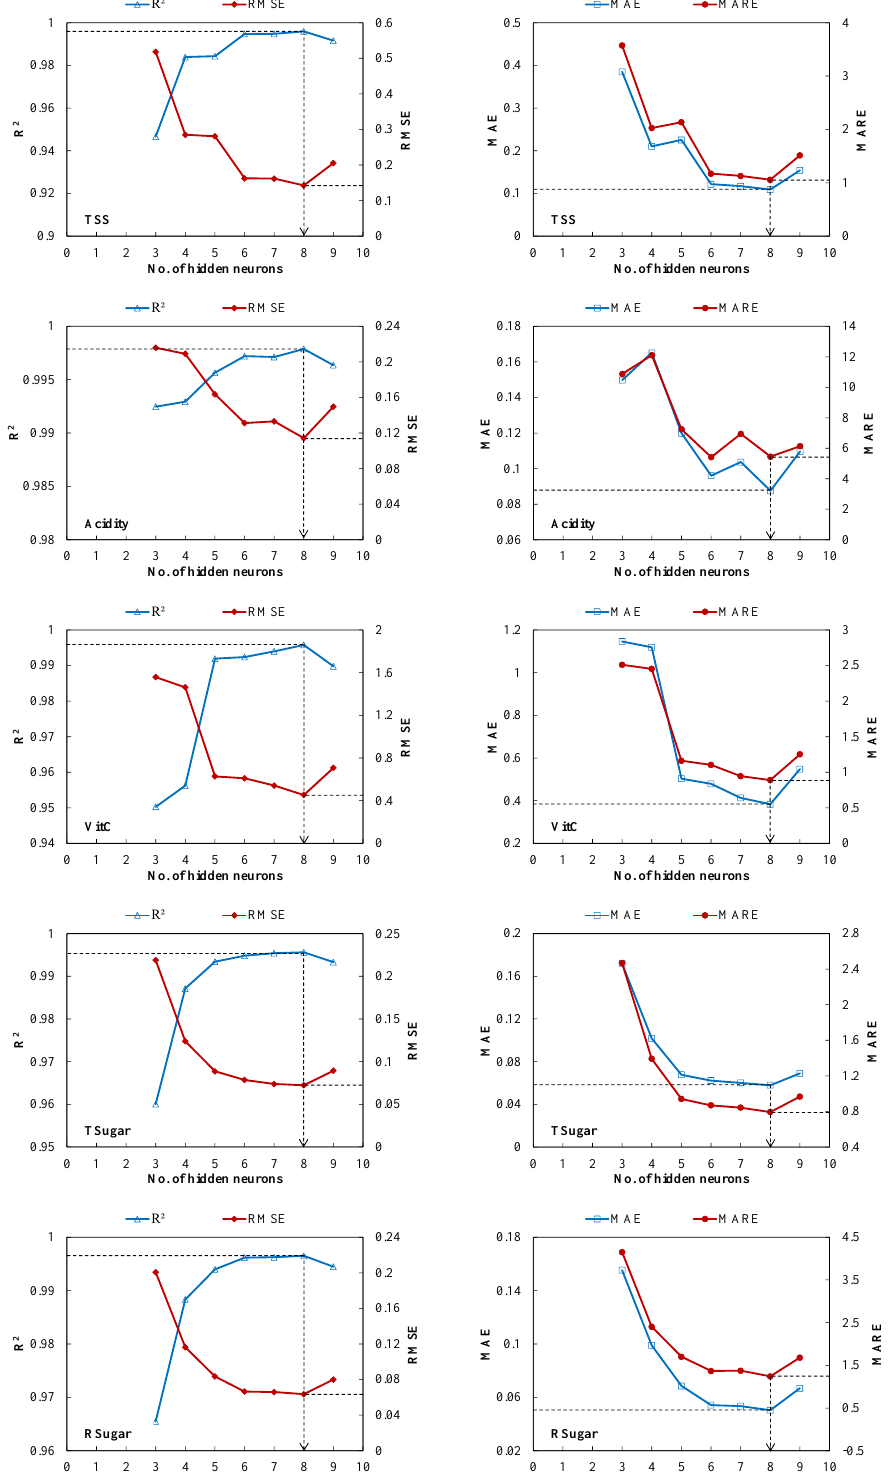
Figure 3. Number of hidden neurons verse statistical performance of the ANN model for total soluble solids (TSS), acidity, vitamin C (VitC), total sugars (Tsugar), and reducing sugars (Rsugar) during the training process. R 2 , coefficient of determination; RMSE, root mean square error; MAE, mean absolute error; MARE, mean absolute relative error.